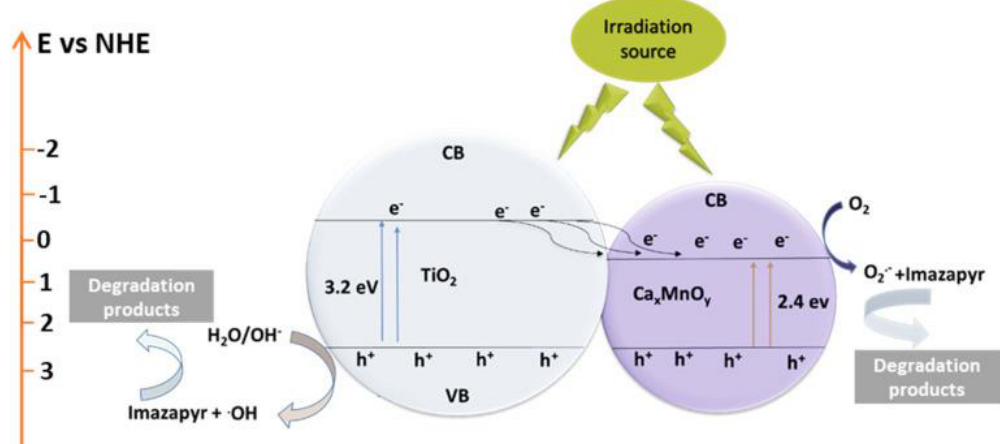
Figure 4. Band scheme for the enhancement in the photocatalytic activity of TiO 2 by Ca x MnO y modification the photodegradation of Imazapyr [16].